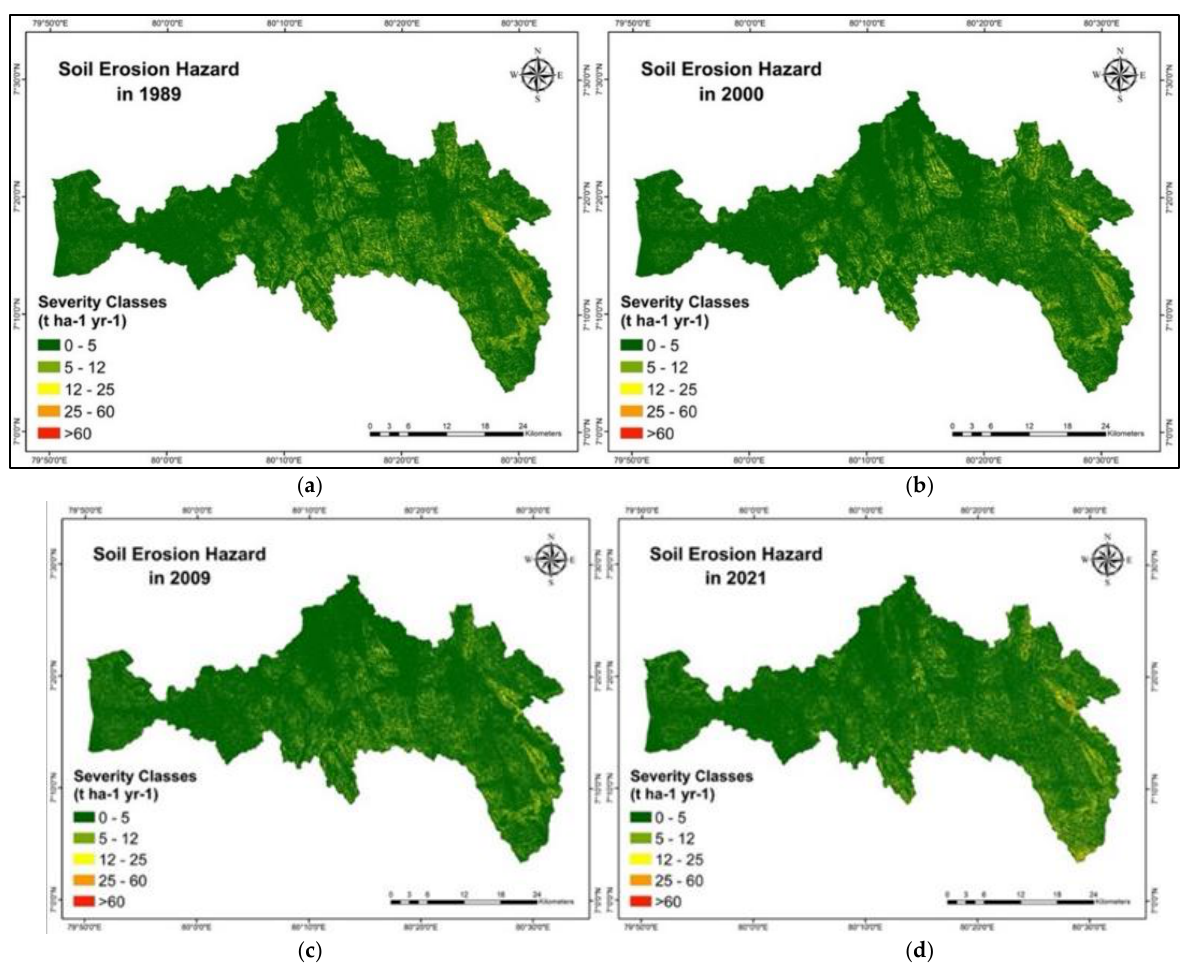
Figure 11. Spatial distribution of soil erosion hazard in MORB for ( a ) 1989, ( b ) 2000, ( c ) 2009, and ( d ) 2021.